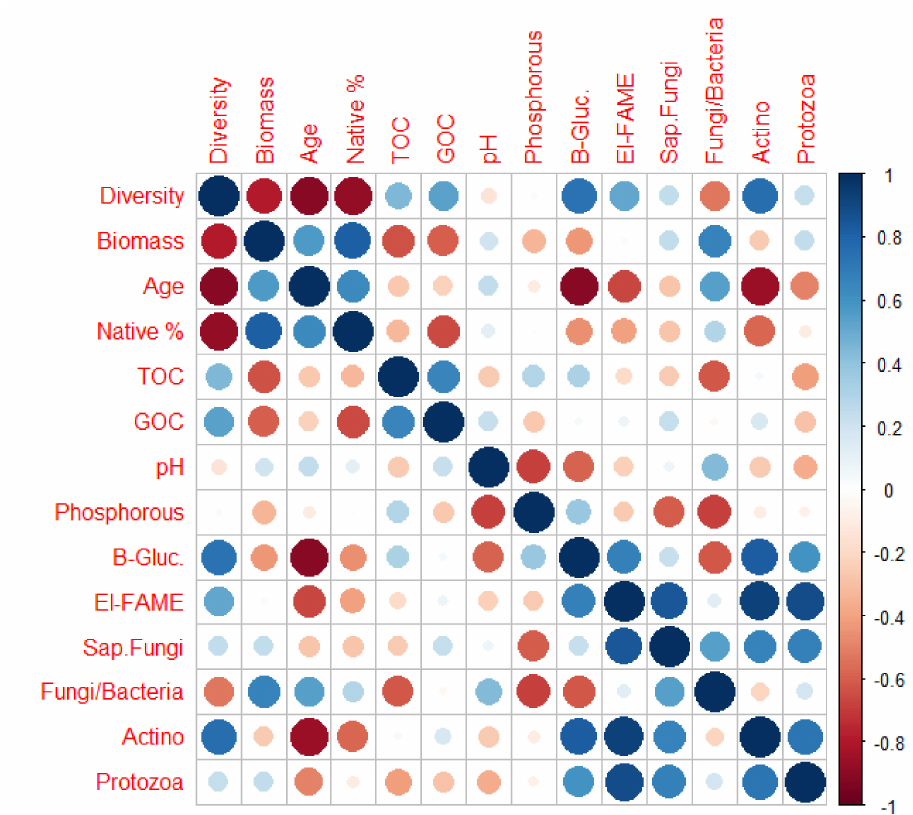
Figure 5. Correlations between vegetation, soil nutrients, and soil microbial data in 2018. Red circles = negative relationship. Blue circles = positive relationship. Larger circles = stronger relationship. Age: time since prairie restoration; Native %: vegetation native percentage cover; TOC: total organic carbon; GOC: geogenic (coal) carbon; B-Glu: betaglucosoidase; Sap. Fungi: saprophytic fungi; Fungi / Bacteria: fungal / bacterial ratio; Actino: